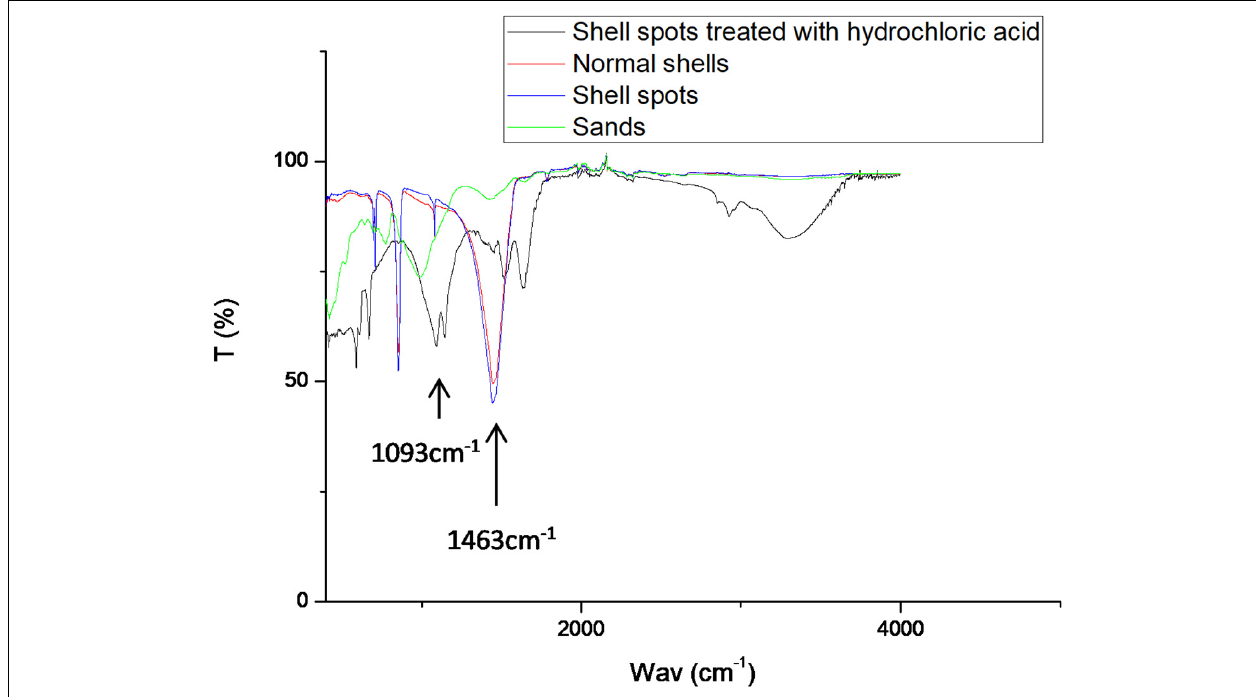
FIGURE 8 | Infrared spectra results of shell spots treated with hydrochloric acid, normal shells, shell spots, and